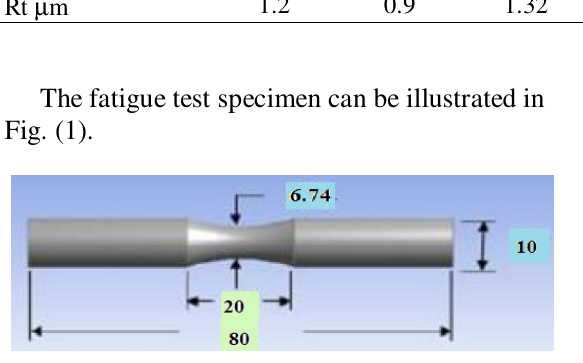
Fig. 1. The specimen dimensions in mm according to (DIN 50113) standard